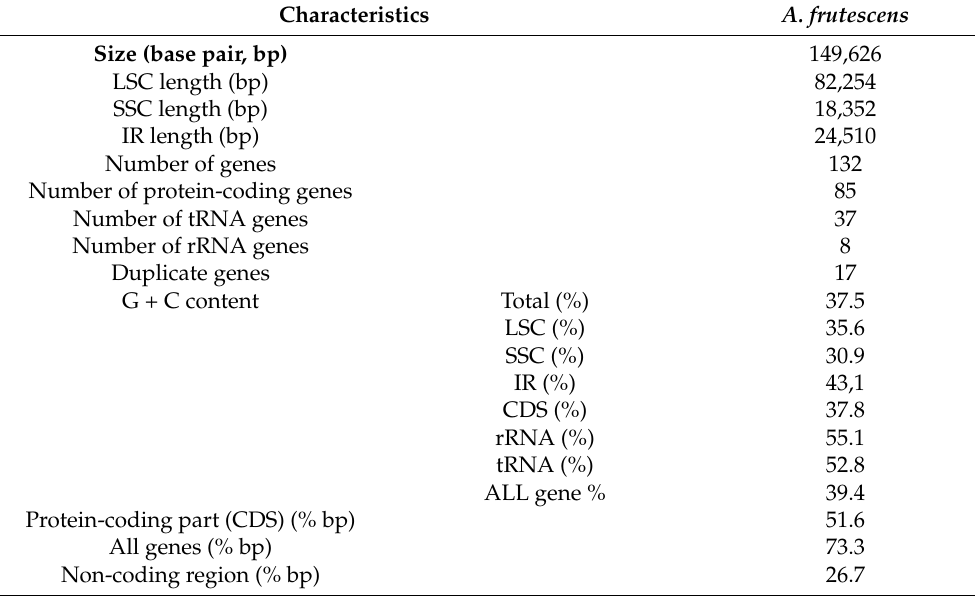
Table 1. Chloroplast genome general features of A. frutescens .